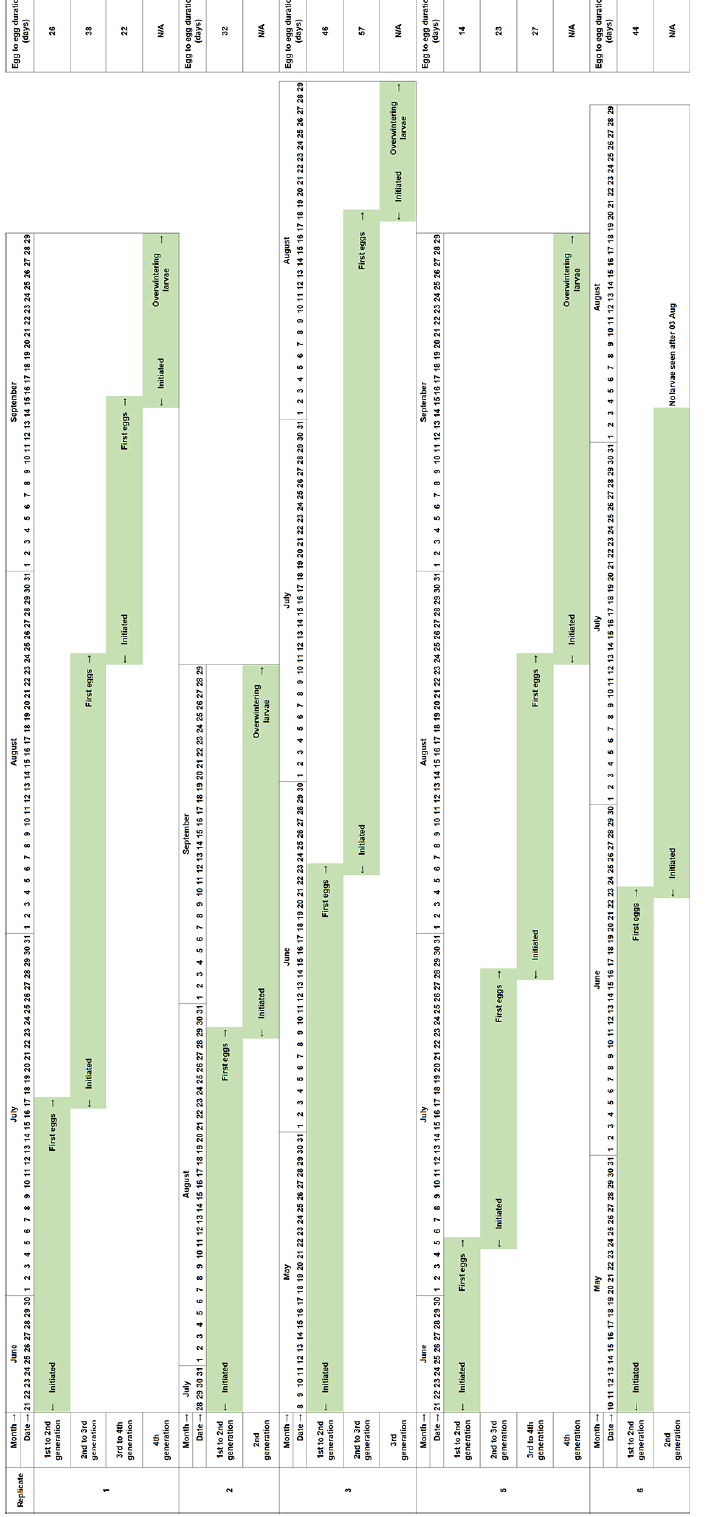
https://doi.org/10.5194/we-22-101-2022 Web Ecol., 22, 101–108,